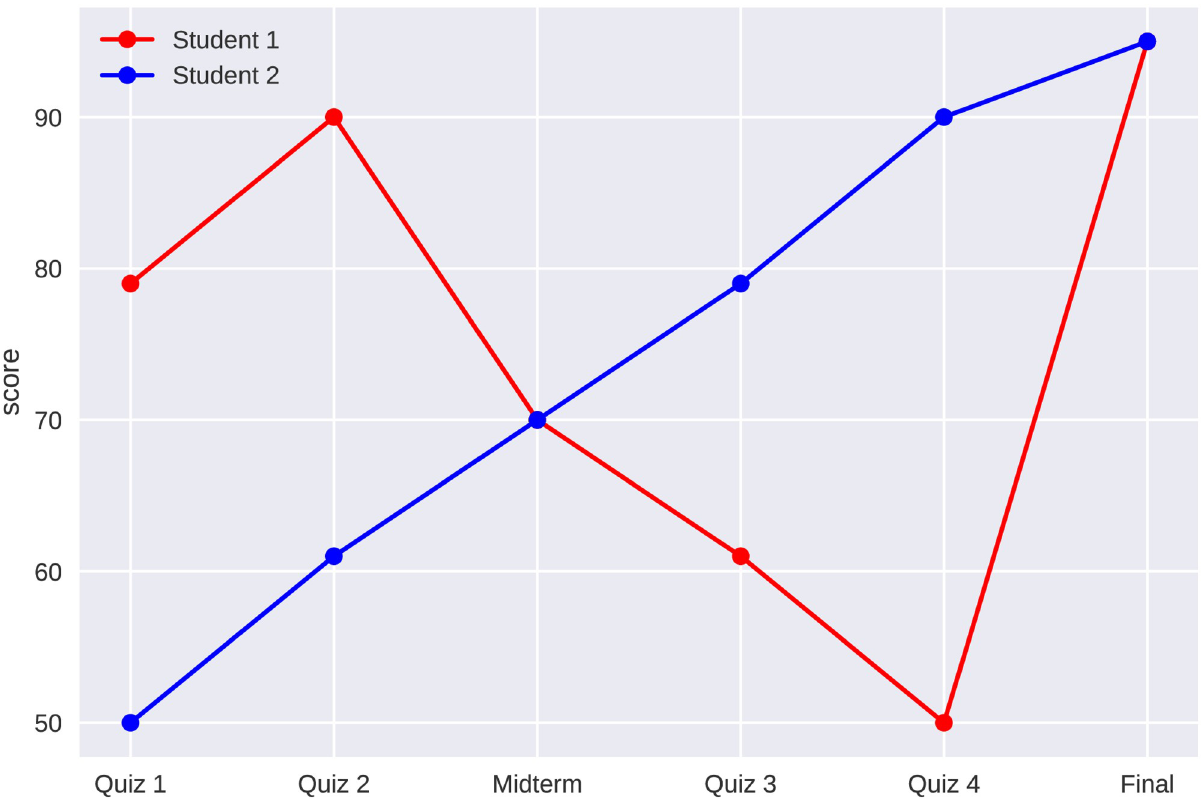
Fig 1. Both sequences of scores consist of the same values, but in different order. The steady progression of grades of Student 2 makes a score of 95 on the final exam seem plausible. On the other hand, the pattern of grades for Student 1 makes a grade of 95 on the final exam highly unexpected.